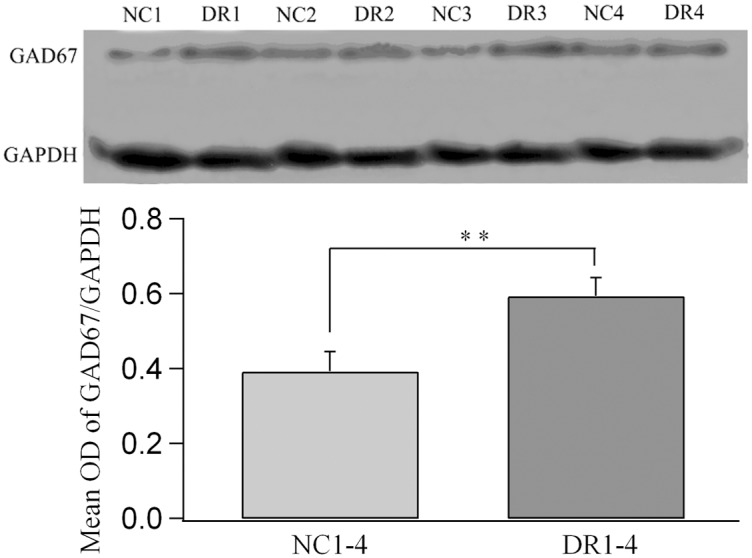
Comparison of the expression levels of GABA-synthesizing enzyme subunit, GAD67, between DR and normal control cats.The top panel shows a typical sample of a Western blot result from each DR cat (DR1-4) and control cat (NC1-4) using GAD67 and GAPDH (glyceraldehyde-3-phosphate dehydrogenase) antibodies. The bottom panel shows the average optical density (OD) of GAD67 bands normalized against the corresponding GAPDH in both groups of cats. The average normalized optical density of GAD67 in DR cats was significantly higher than that in the control (** p<0.01).